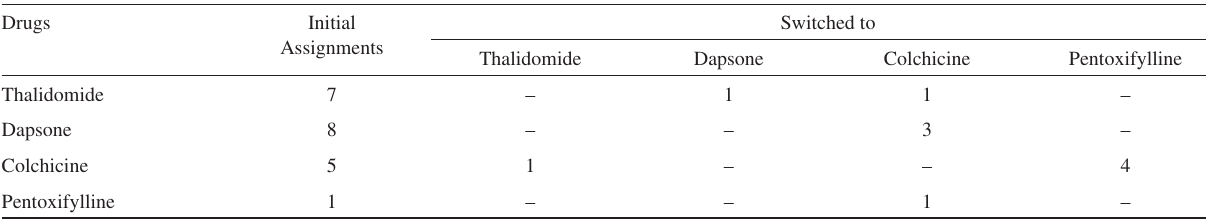
Table 3 - Drug assignments (n =